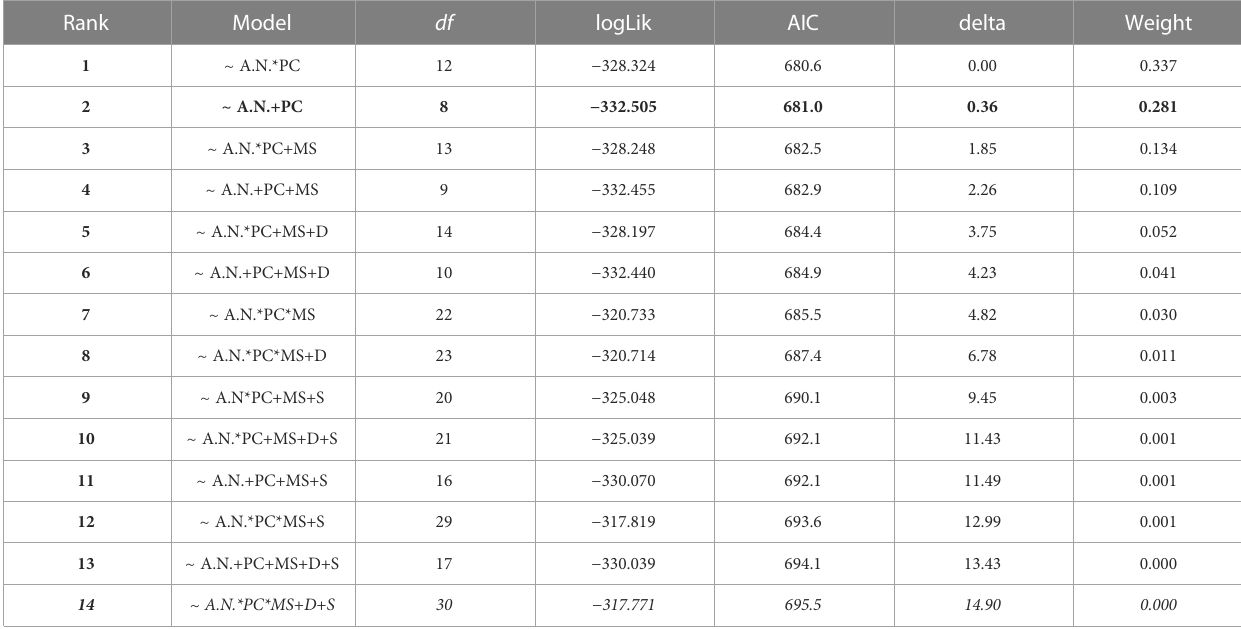
TABLE 4 Model selection AIC ranking